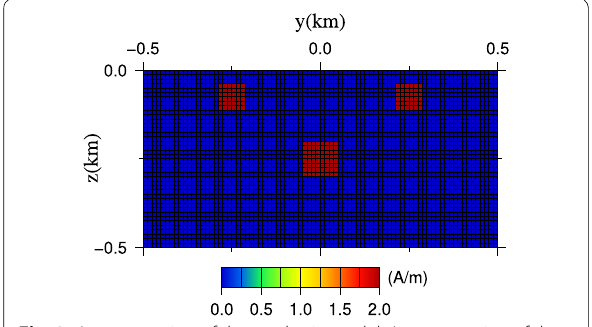
Fig. 3 A cross-section of the synthetic model. A cross-section of the synthetic model of Fig. 2 through the x